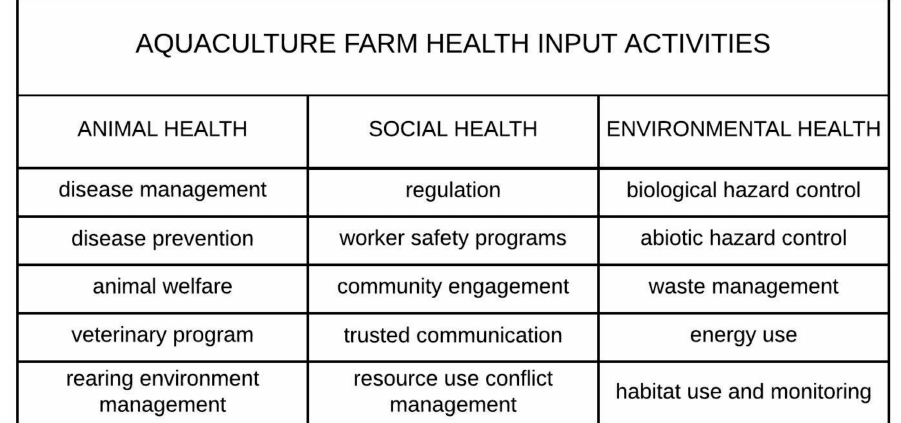
Figure 2. Farm-level activities that can influence inputs in the logic model and provide data for to an aquaculture well-being